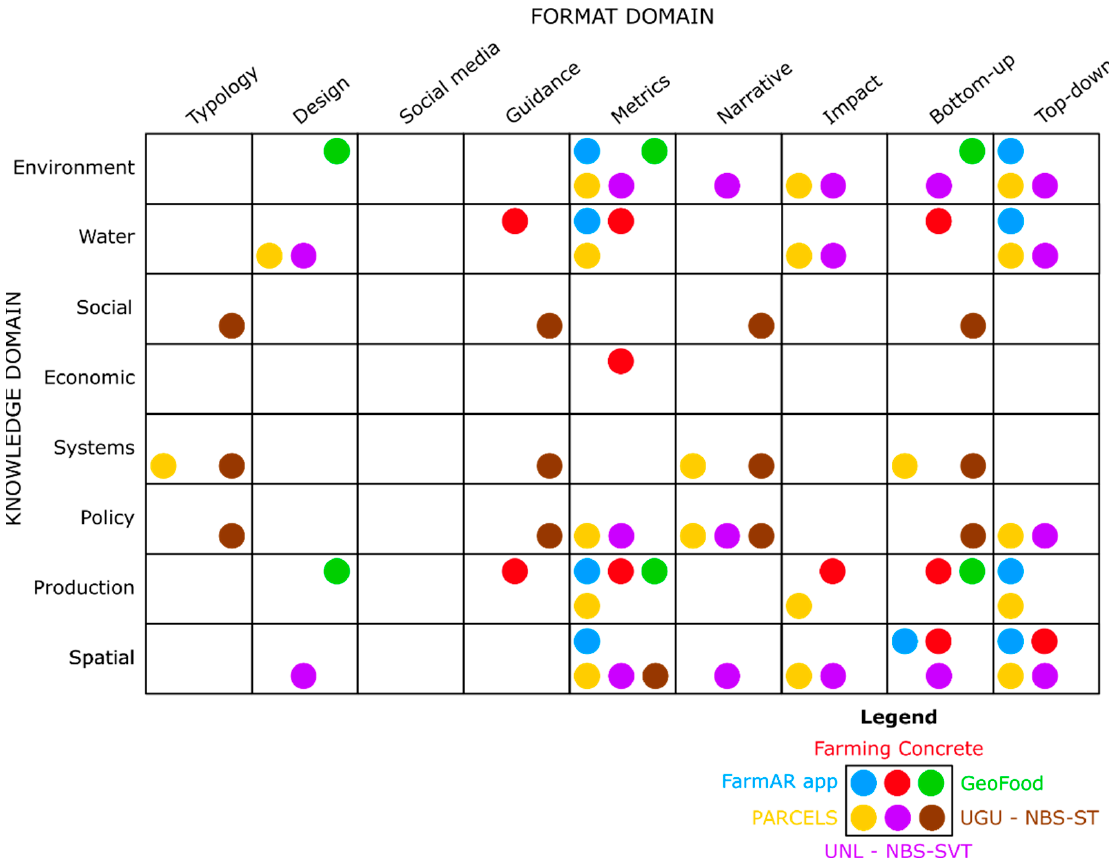
Figure 7. Location of model-based tools in a two-dimensional grid, where the x axis represents the format domains and the y axis represents the knowledge domains. Coloured dots represent the six different model-based tools further analysed.